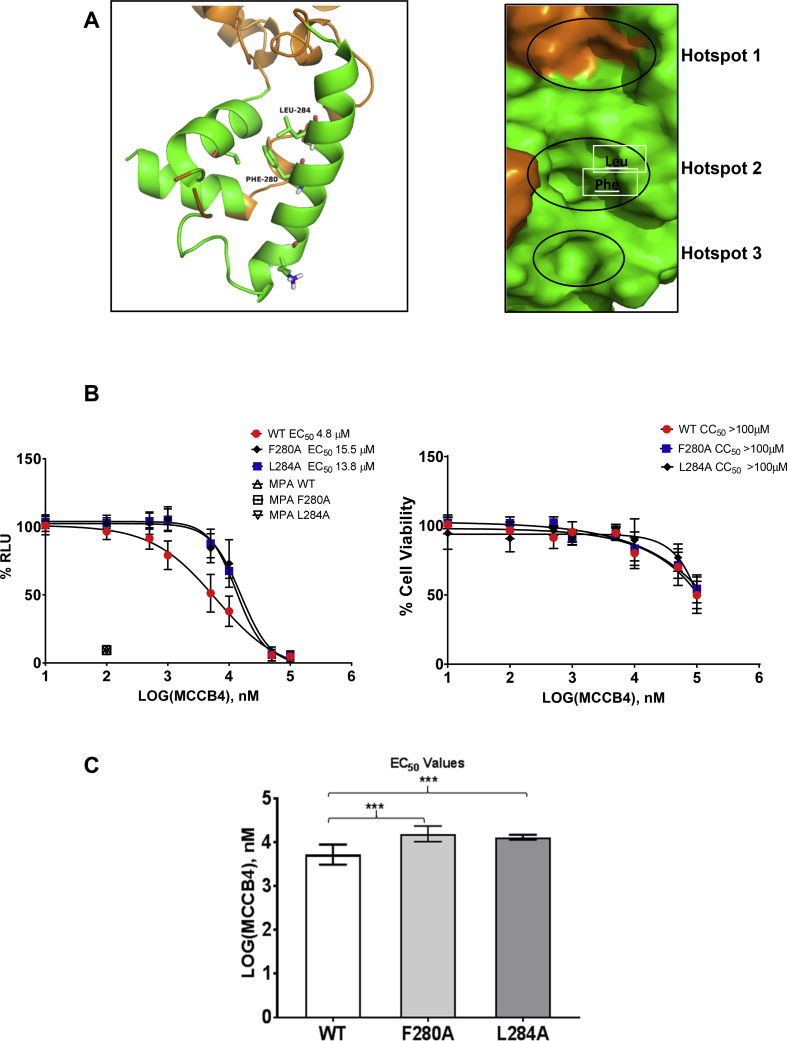
Mutagenic analysis of NP confirms the mode of action of MCCB4. A. The EBOV NP hotspot 2 residues Phe280 and Leu284 were mutated to alanine (F280A and L284A, respectively). B. EC50 curve of percentage reduction in luciferase. MCCB4 was added to cells at 100, 50, 10, 5, 1, 0.5, 0.1, and 0.01 μM immediately before transfection with either wildtype EBOV NP, mutant F280A or L284A. Cells were harvested at 24 hpt and analysed for Firefly luciferase. Values are represented as percentages of a transfection only control. C. Comparison of EC50 values generated from the wildtype NP or mutant NP transfections. EC50 values from 3 independent experiments performed in triplicate were plotted and compared using an unpaired two-tailed t-test. Error bars show SD. *** P Value < 0.001.